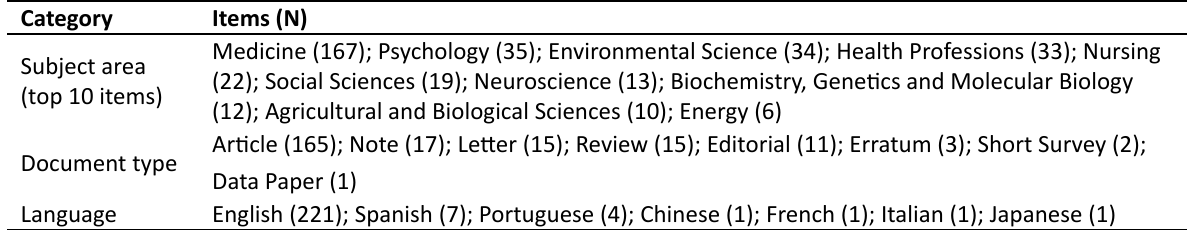
Table 1. Research sample